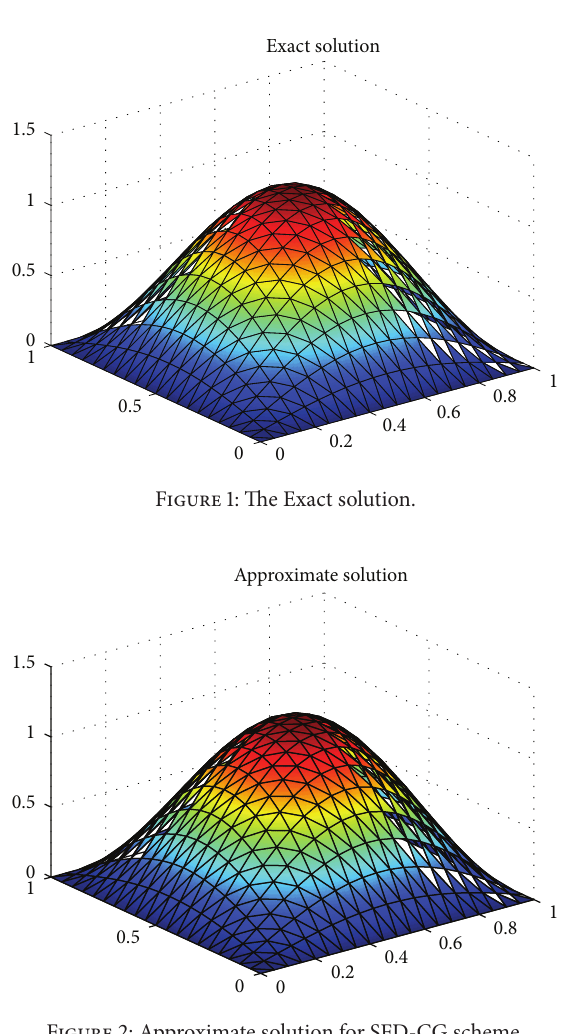
Figure 2: Approximate solution for SFD-CG scheme.